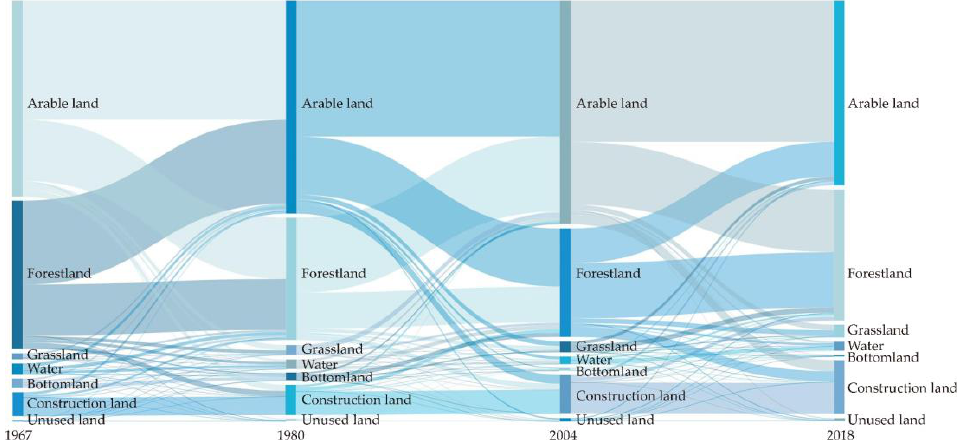
Figure 4. Land use transfer from 1967 to 2018.